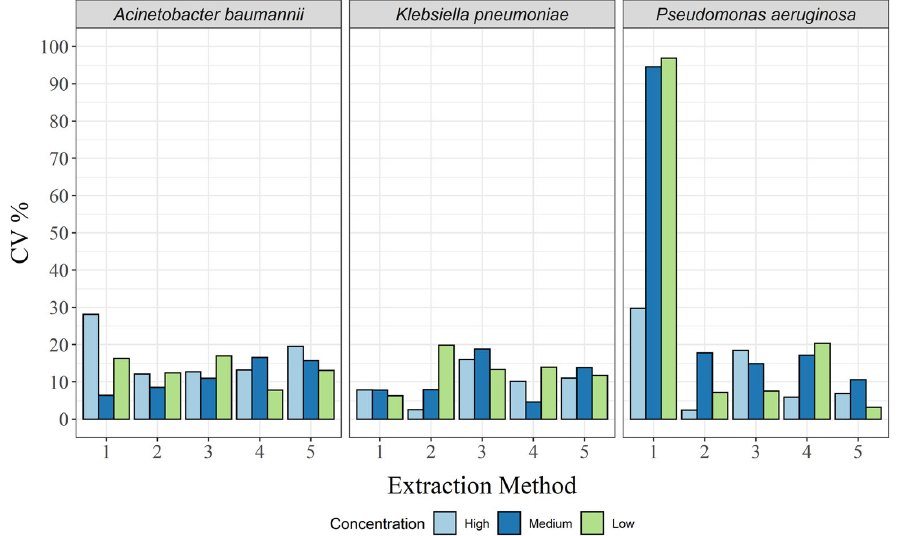
Figure 3. Intermediate precision in CV%, for each of the three bacterial species and for all extraction methods: 1, CTAB; 2, QIAamp DNA mini kit; 3, GXT NA extraction kit; 4, QuickPick genomic DNA extraction kit; 5, DNeasy UltraClean microbial kit.